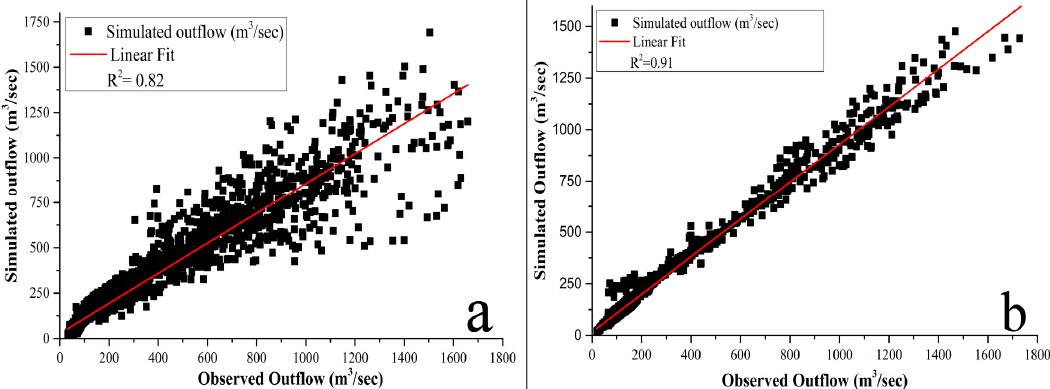
Figure 5. Comparison of observed and simulated daily outflow calibration ( a ) and validation ( b ) periods of the Danyore Gauge station. Table 4. Statistical assessment of simulated and observed model